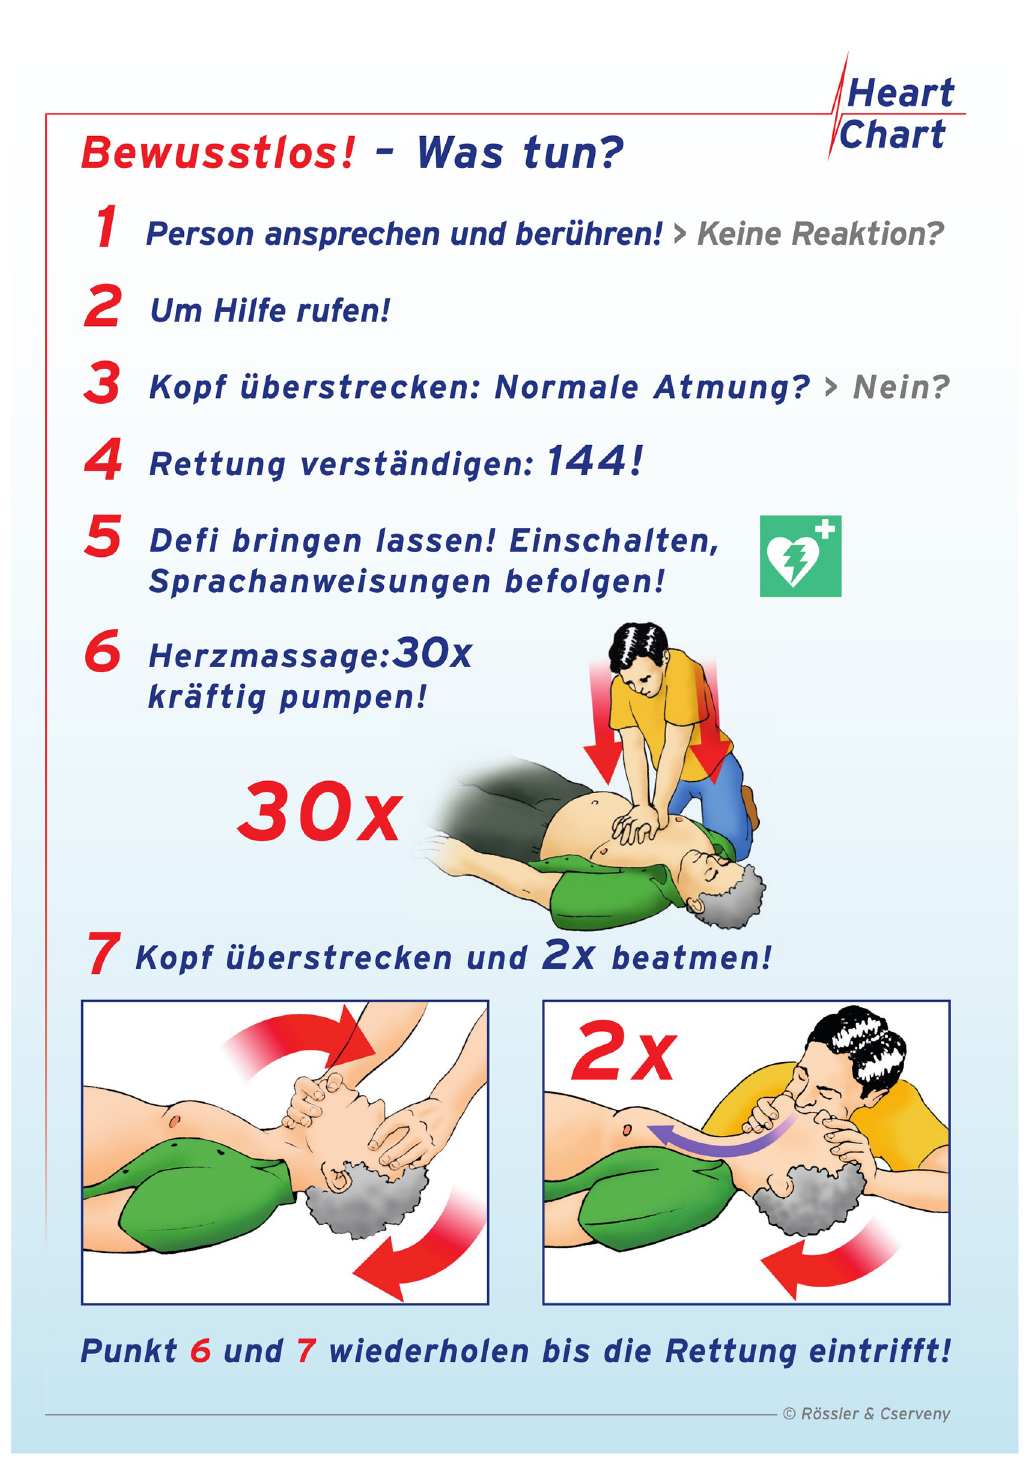
Fig 1. Flowchart of standard CPR. Unconscious!—What to do? 1. Speak to and touch the collapsed person! No reaction? 2. Shout for help! 3. Open airway: Breathing?—No? 4. Dial emergency medical service: 144! 5. Send for an Automated External Defibrillator: Activate and follow voice instructions! 6. Chest compressions: 30x Push hard! 7. Open airway and give two mouth-to-mouth ventilations. Repeat 6 and 7 until emergency medical service arrives.